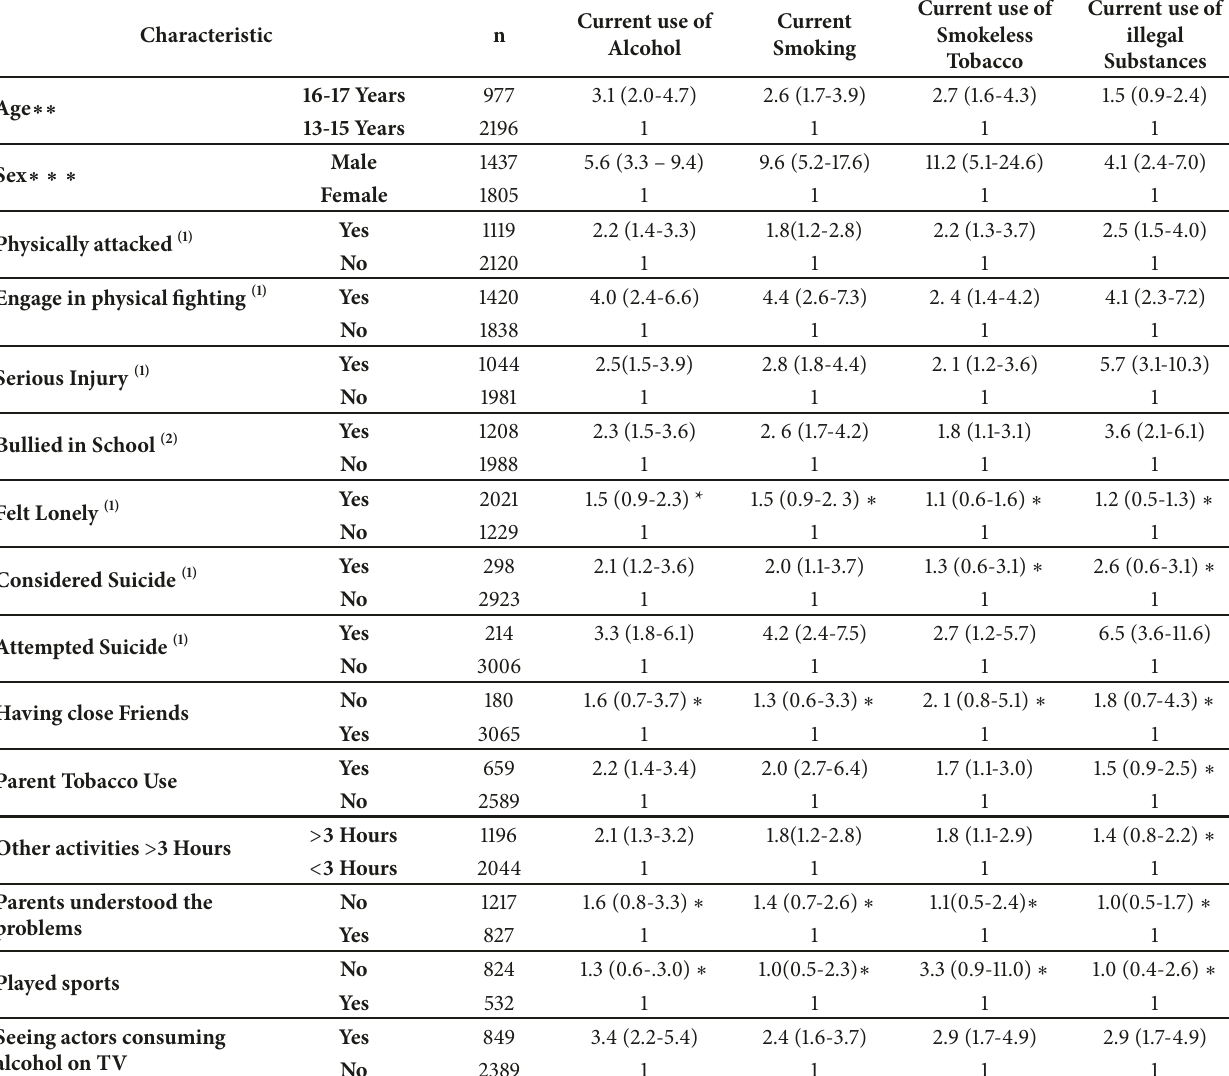
Table3:Factorsassociatedwithcurrentuseofalcoholconsumption,smoking,smokelesstobacco,andillegalsubstances(ageandsexmatched Odds Ratios with 95%